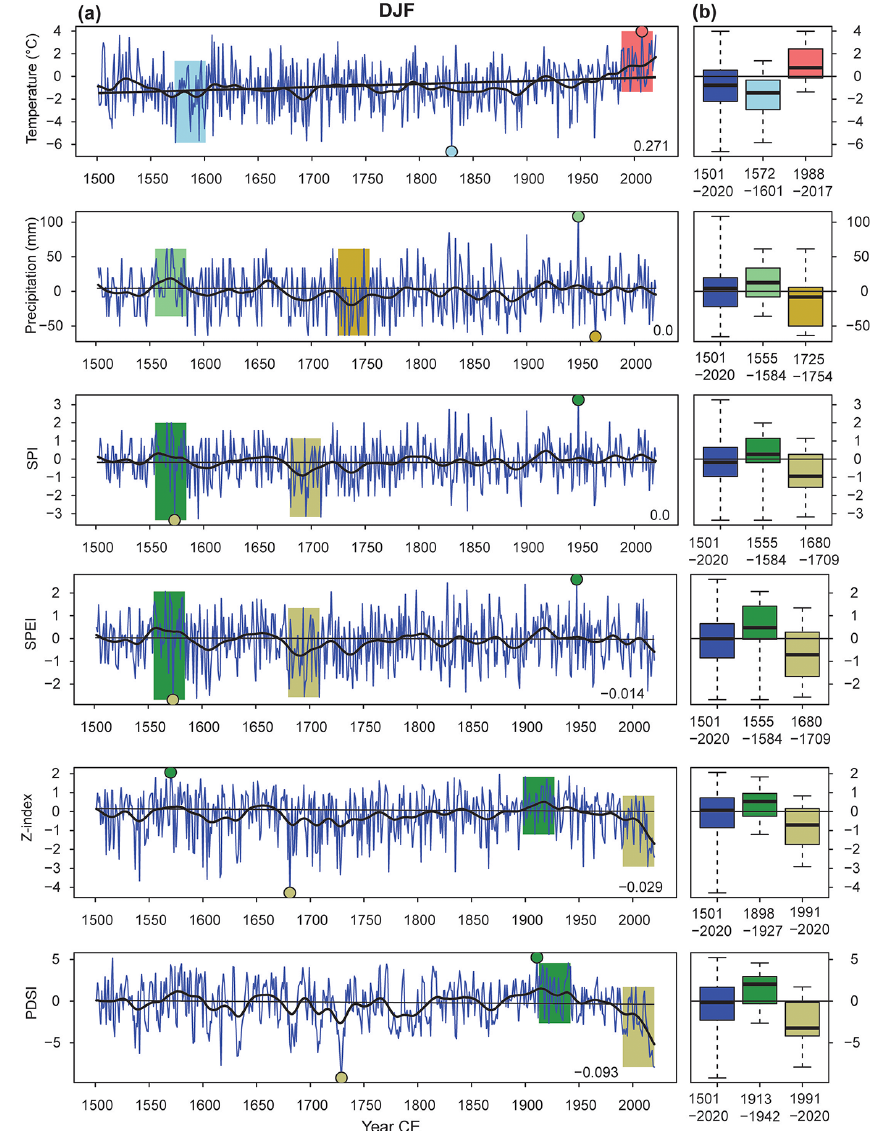
Figure 3. See text in Fig. 1;